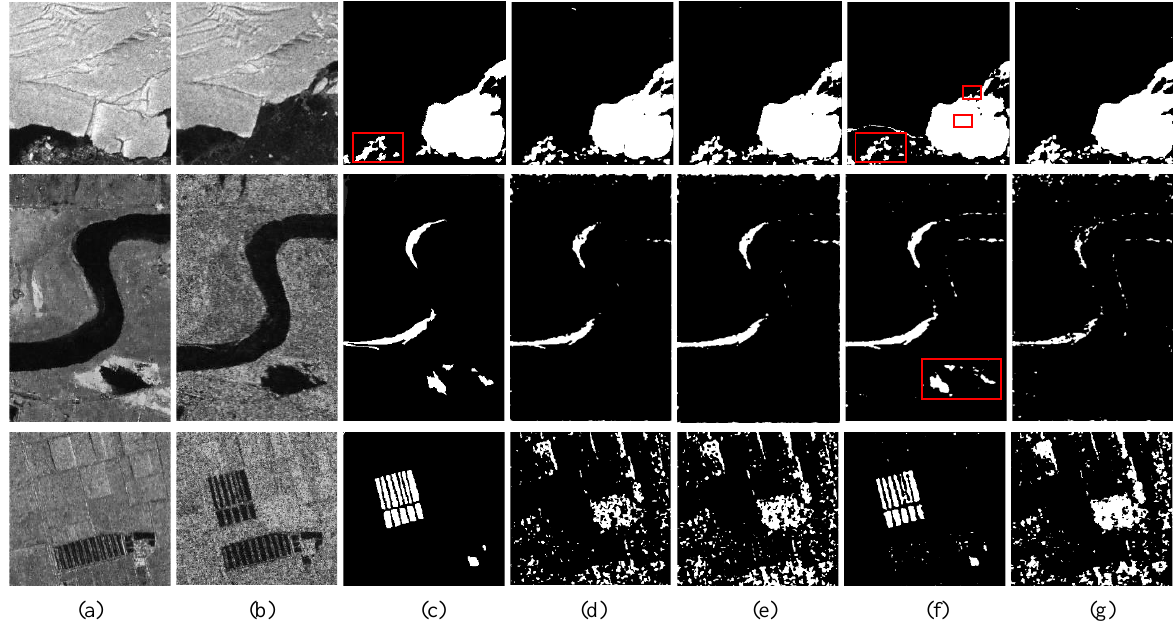
Figure 6. Visualized change detection results for different pre-trained networks on the SAR dataset, Sulzberger dataset (first row), YellowRiver-Inland water (second row), YellowRiver-Farmland (third row). (a) Image captured at 𝑡 1 . (b) Image captured at 𝑡 2 . (c)